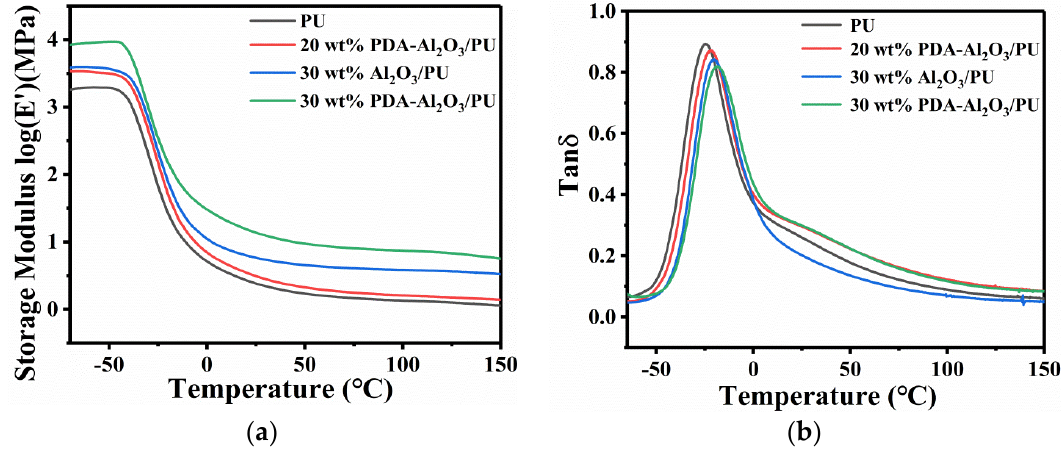
Figure 10. The relationship between storage modulus ( a ) and loss factor ( b ) of Al 2 O 3 / PU and PDA-Al 2 O 3 / PU composites with respect to temperature.